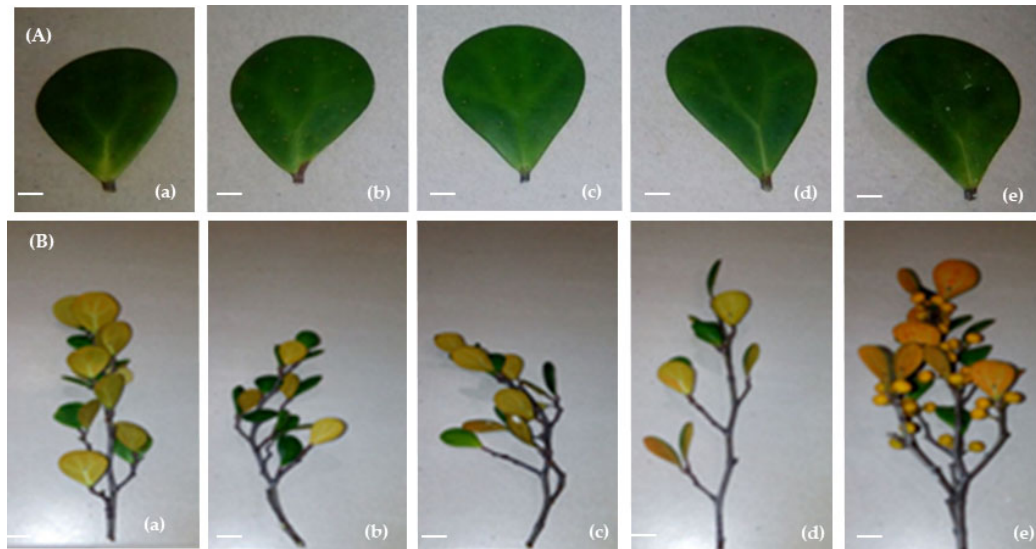
Figure 1. The effects of H 2 O 2 on ( a ) seedling height, ( b ) leaf area of mature leaves, ( c ) number of leaf, and ( d ) number of syconium of F. deltoidea plants. Bars represent means ( n = 7) ± standard error (S.E.). a, b, and c indicate significant differ ‐ ences within each growth period ( p < 0.05, Tukey’s Honestly Significant Difference (HSD) ‐ test)).